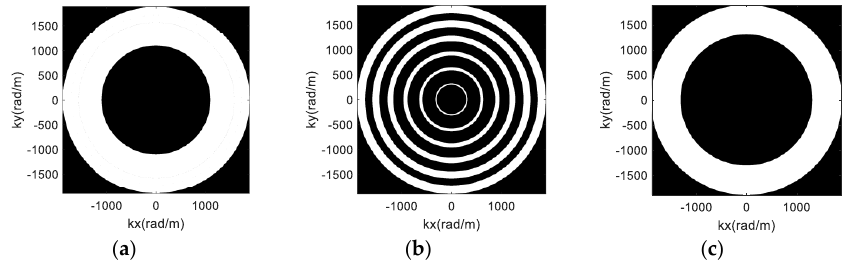
Figure 8. The spectral supports of different array configuration: ( a ) Optimized array; ( b ) Uniform Figure array 1; ( c ) Uniform array 2.